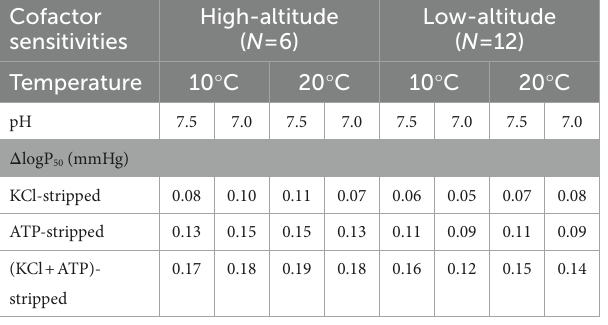
P 50 and n 50 values were expressed as means ± SE. Six technical replicates have been carried out for each condition. TABLE 4 Anionic allosteric cofactor sensitivities of high- and low-altitude black spotted frogs Hbs under different experimental